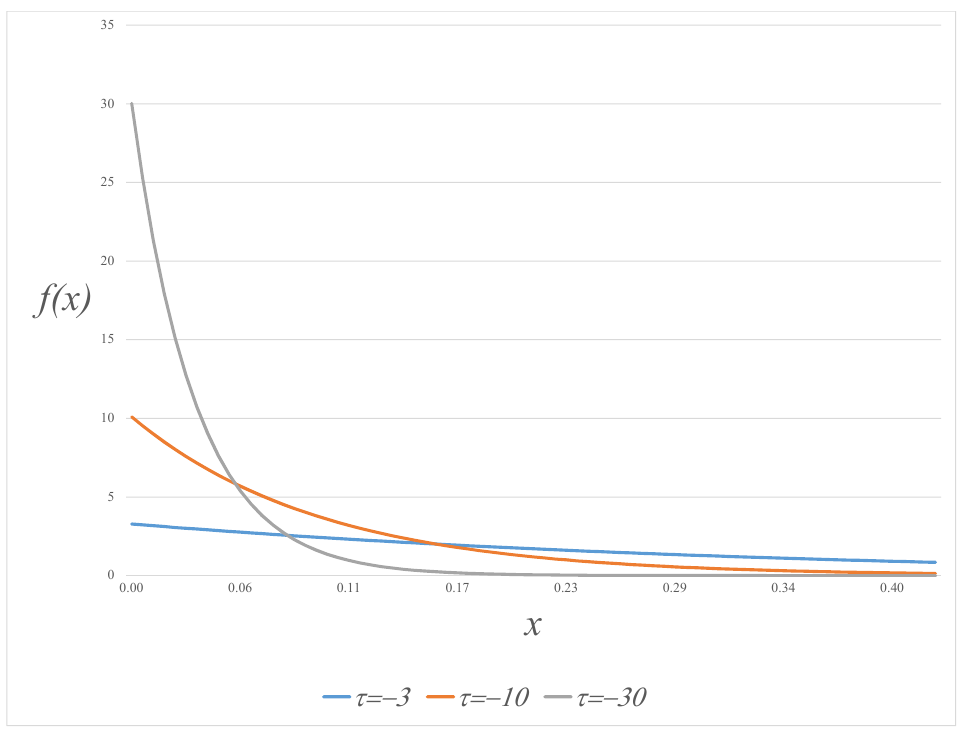
Figure 2. Truncated normal density function τ = − 3, − 10, −